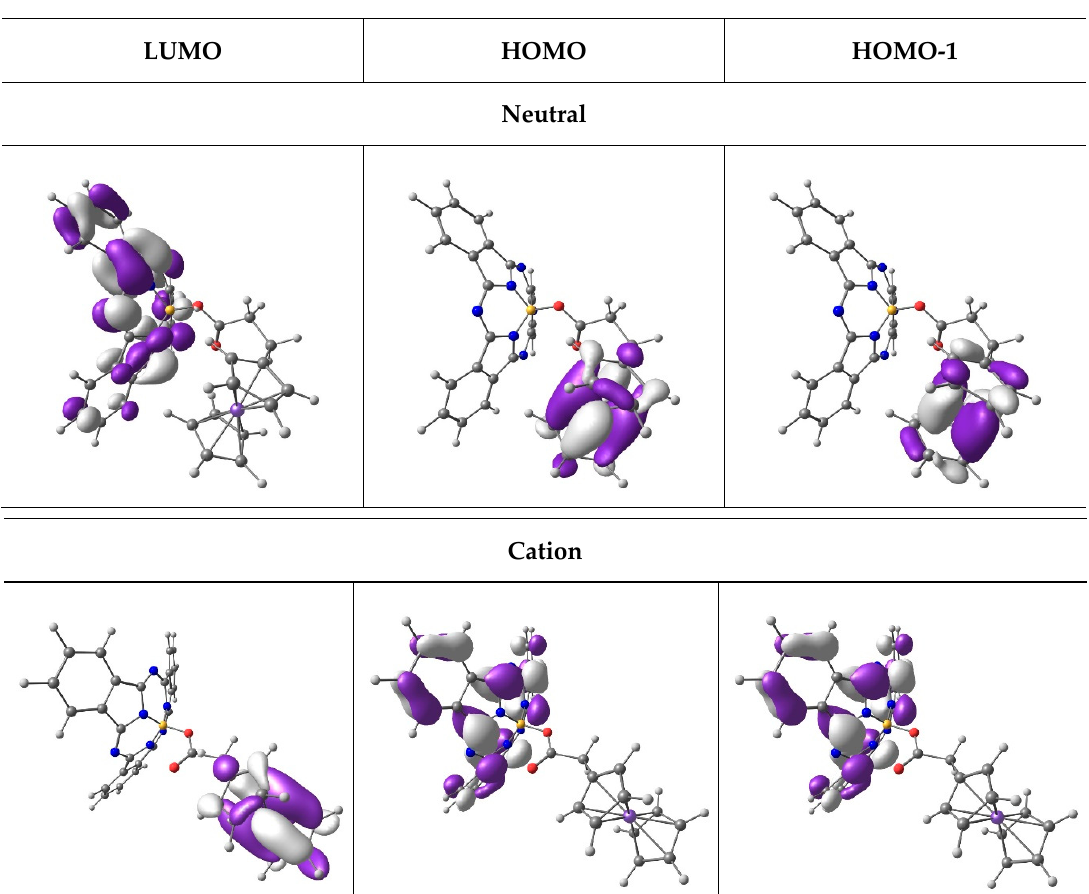
Figure 5. Selected PBE1PBE/6-311G(d,p) frontier molecular orbitals (MOs) for cation SubPc, 8 . A contour of 0.03 e/Å 3 was used for the orbital plots. Colour code of atoms (online version): Fe (purple), B (yellow), C (grey), O (red), H (white). HOMO = highest occupied molecular orbital and LUMO = lowest unoccupied molecular orbital.